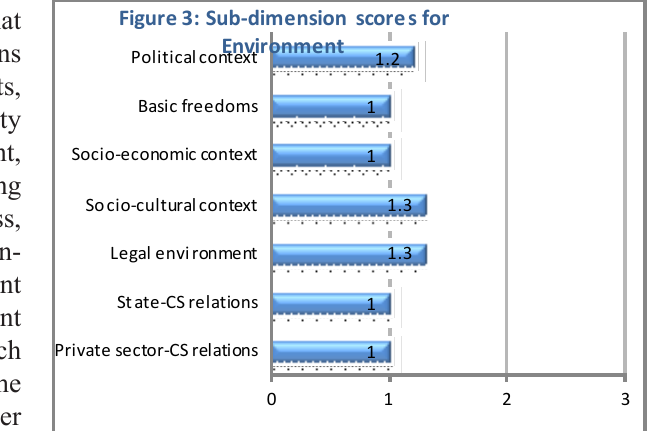
Figure 3: Sub-dimension scores for